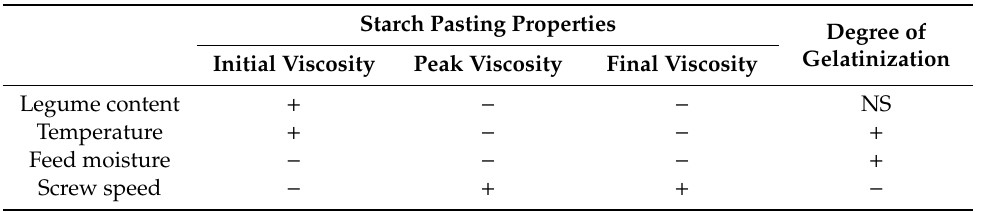
Table 3. E ff ect (positive / negative) of the increase in the main processing parameters of extrusion cooking on the starch characteristics of legume extrudates. Starch Pasting